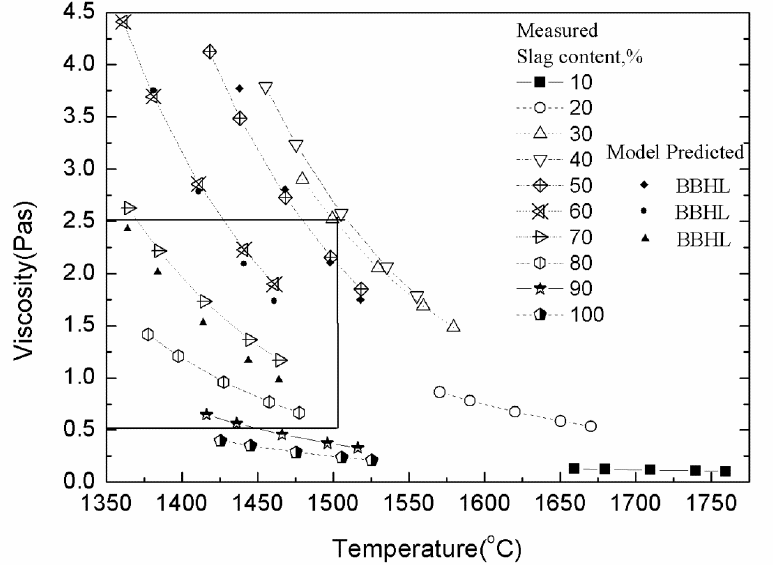
Figure 4. Viscosity of samples measured with the inner cylinder rotation